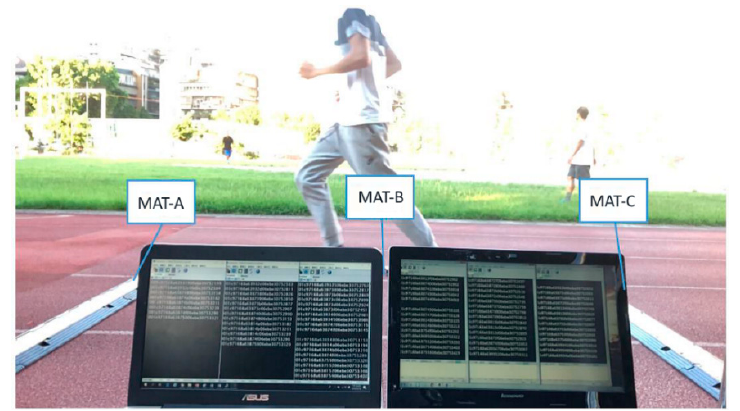
Figure 17. The dynamic experiment of three sets of MAT when a BLE Tag is on the runner’s chest. Table 11. The dynamic experiment of three sets of MAT when a BLE Tag is on the runner’s chest. On Chest Tx Level 4